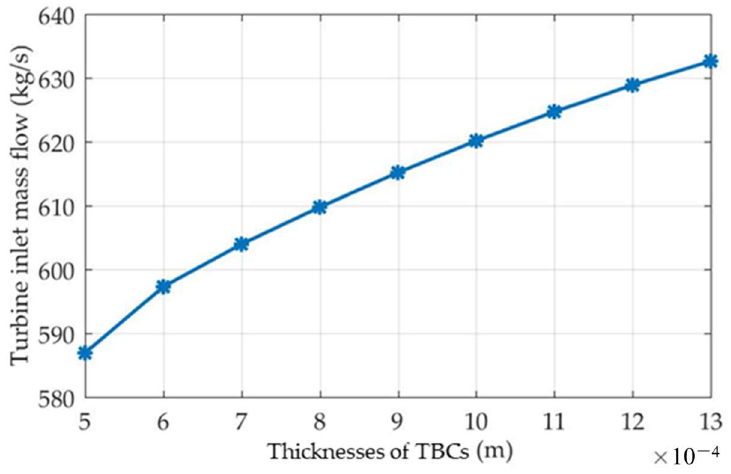
Figure 9. The relationship between the turbine inlet mass flow rate and TBC thickness.